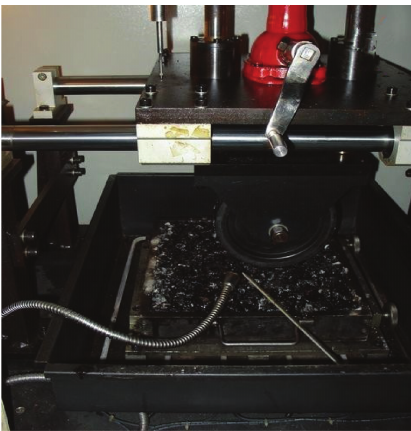
Table 4: Basic parameters of shear strength of the 100mm ×